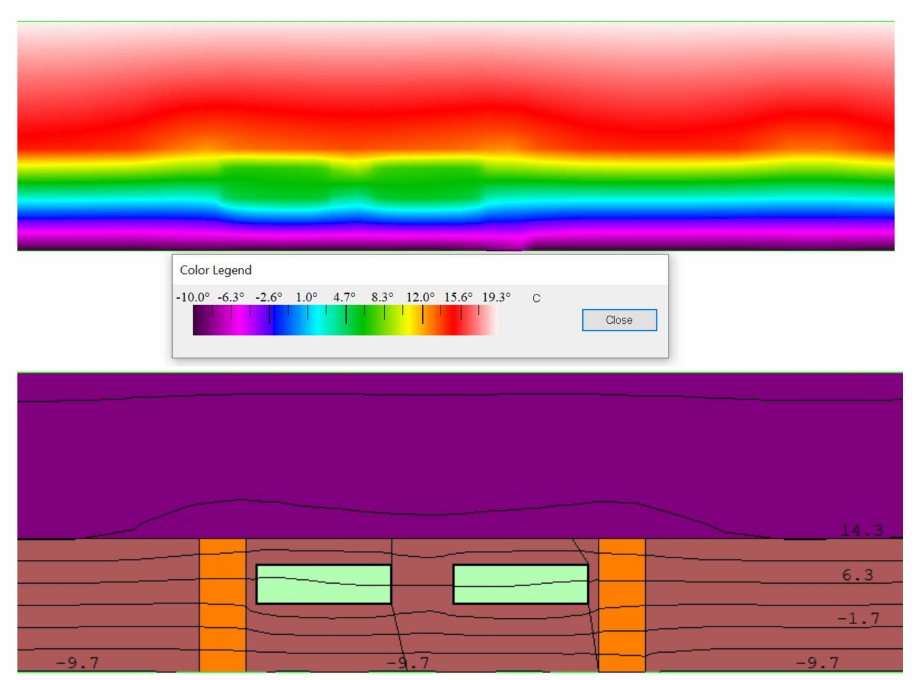
Figure 7. Impact of plastic pipe integration.